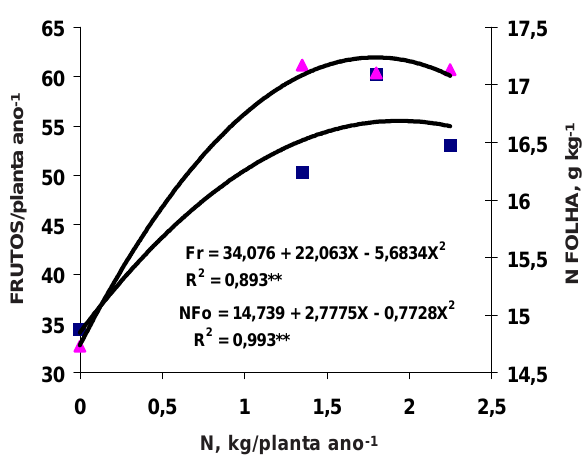
Figura 1. Número de frutos por planta por ano (Fr = n ) e teores de N na folha 14 do coqueiro (NFo = ), em função das doses de N-uréia na Areia Quartzosa. ** significativo a